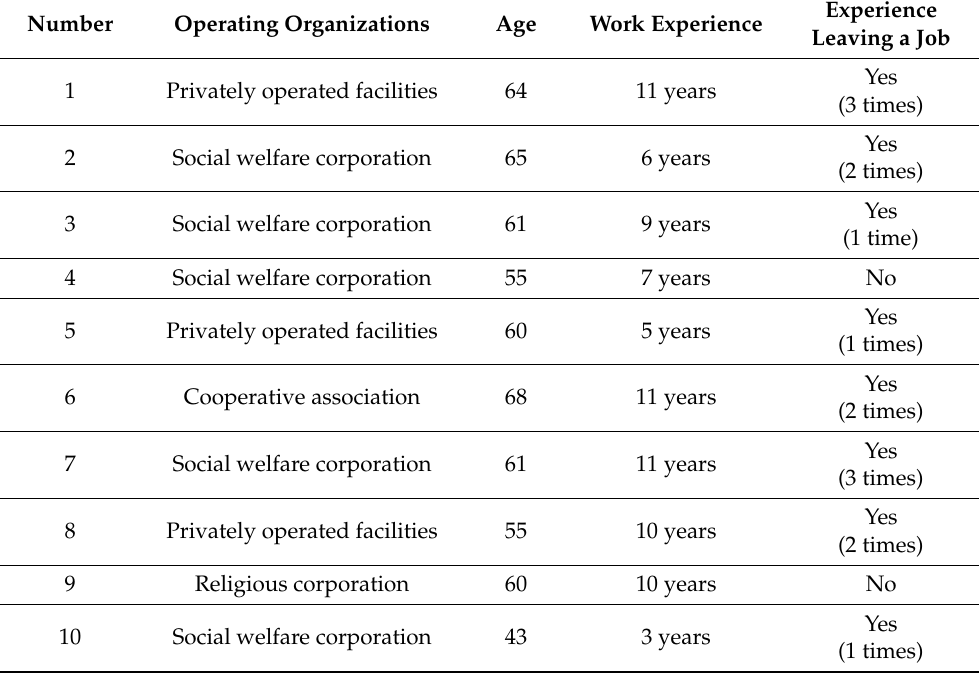
Table 1. Characteristics of